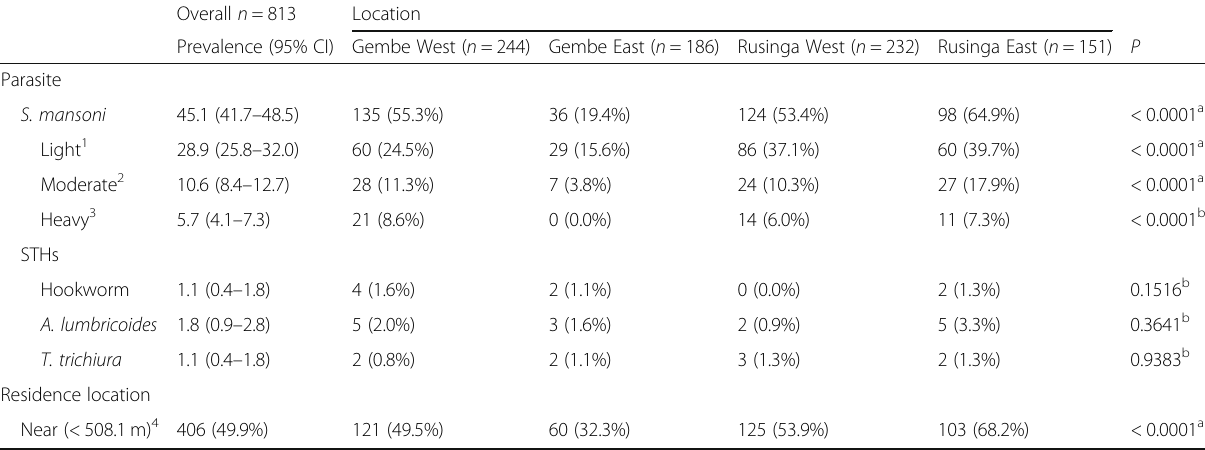
Table 1 Prevalence and intensity of S. mansoni and STHs among preschool children in Mbita, western Kenya Overall n =